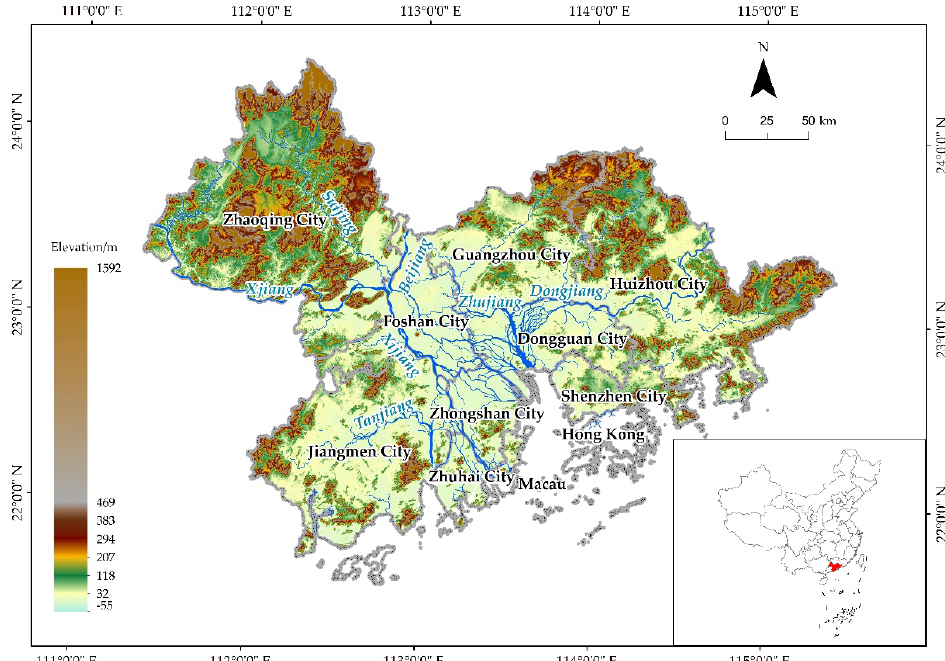
Figure 2. Elevation of the Pearl River Delta region (PRD).